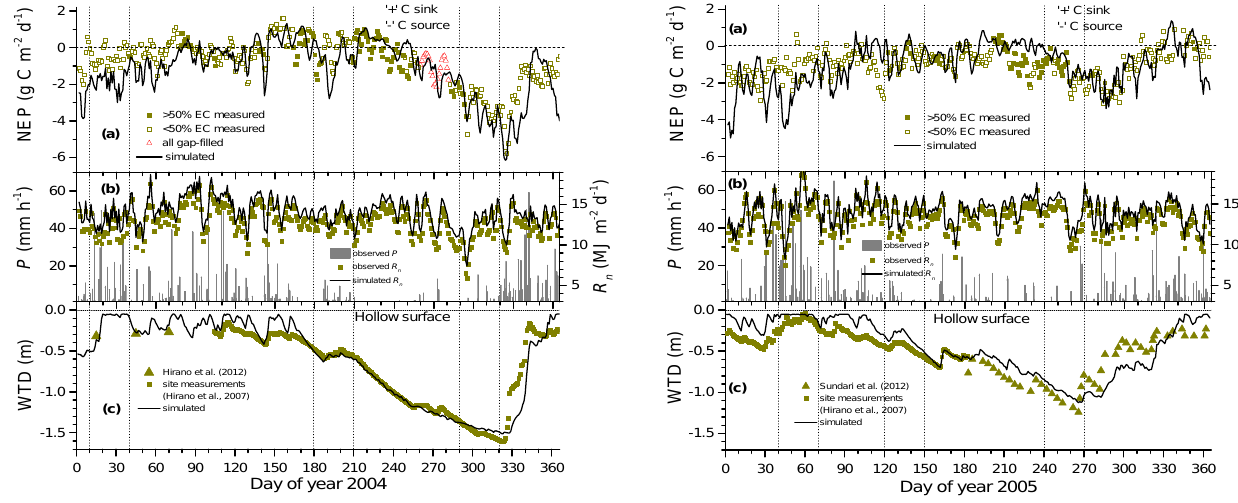
Fig. 5. (a) Three day moving averages of simulated and EC-gap filled estimates of net ecosystem productivity (NEP). Solid squares indicate sums of 24 values more than 1/2 of which were recorded at u ∗ (friction velocity) >0.17ms − 1 and open squares indicate sums of 24 values more than 1/2 of which were gap-filled; (b) hourly measured precipitation ( P) and three day moving averages of simu- lated and measured net radiation ( R n ) ; and (c) daily measured (val- ues digitally obtained from Sundari et al., 2012 and measured in situ as mentioned in Hirano et al., 2007) and modelled water table depths (WTD) from hollow surface during 2005 over a drainage af- fected tropical peat swamp forest at Palangkaraya, Indonesia. Neg- ative values of WTD mean depths below the